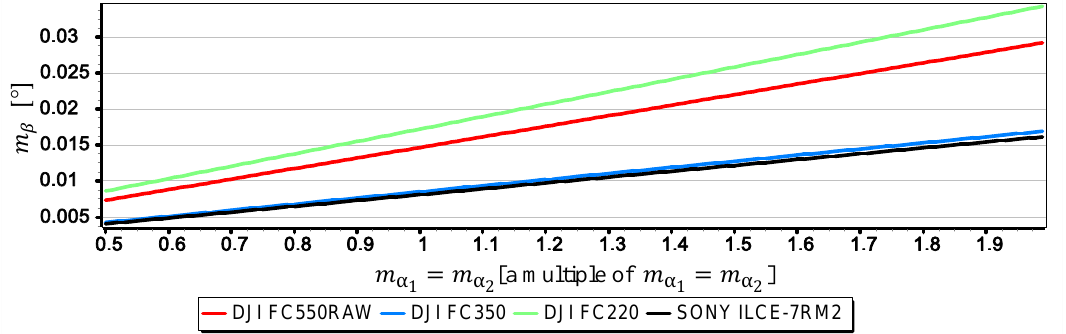
= m α for β = 15 ◦ (only the last two 1 2